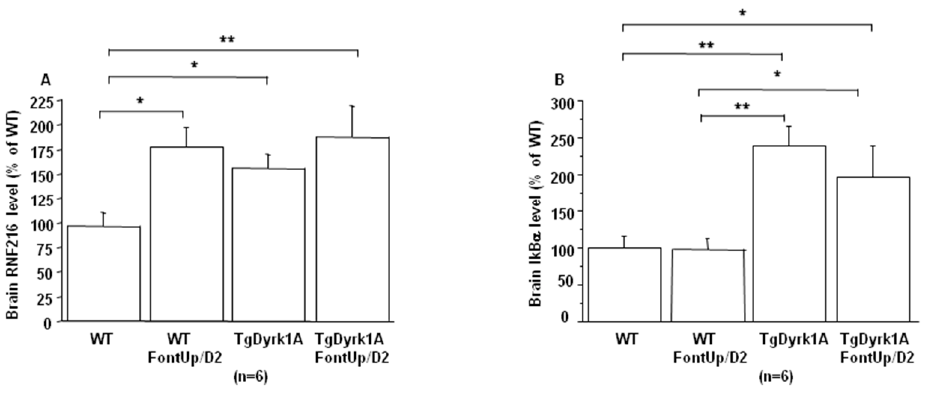
Figure 7. Comparison of brain RNF216 ( A ) and IkB α ( B ) level based on slot blot analysis obtained from WT and mice overexpressing Dyrk1A (TgDyrk1A) after oral gavage of D2 FontUp ® during two days (FontUp / D2). Values were obtained by normalization of images from RNF216 or IkB α to total proteins marked with Ponceau-S. The values are mean ± SEM of n (number of mice) mice normalized to the mean of WT mice fed without FontUp ® . Statistical analysis was done as mentioned in data analysis. * p < 0.05; ** p < 0.005.